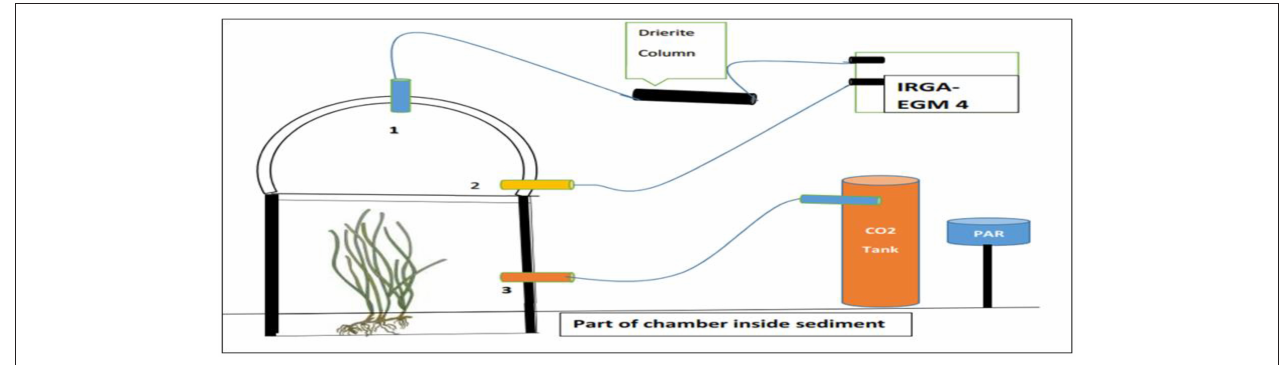
FIGURE 2 | A diagrammatic representation of the incubation work. (1) Port one on top of dome. (2) Port two on ring. (3) Port three for CO 2 injection.